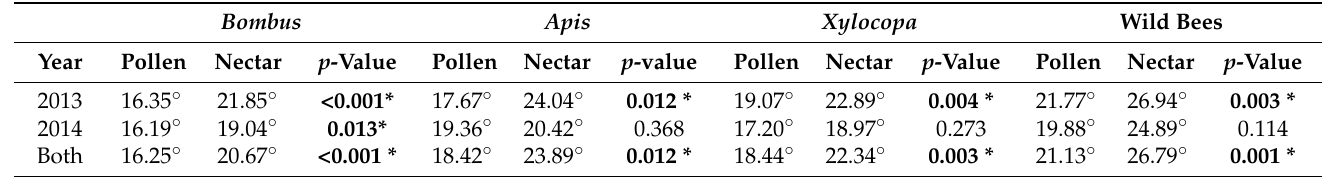
Table 7. Foraging on pollen vs. foraging on nectar flowers: The mean ambient temperature for each of the four bee categories while foraging for nectar or for pollen, with the significance of the differences between nectar and pollen.